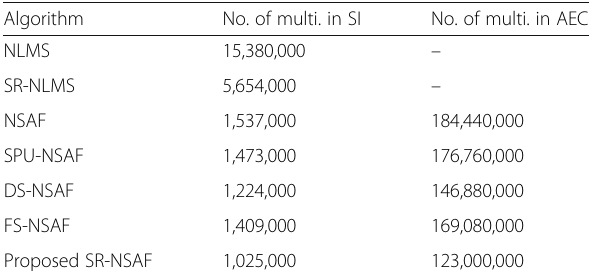
Table 5 Number of multiplications for various NSAF algorithms until convergence in SI and AEC applications